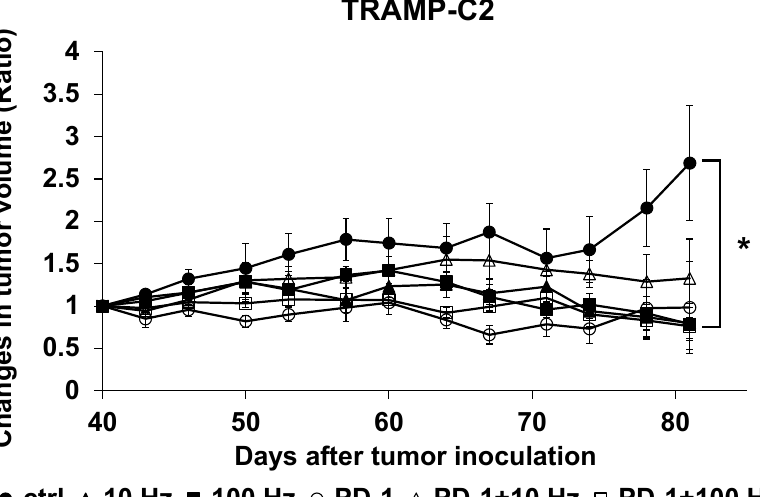
Figure 4. In vivo tumor inhibitory effects of US irradiation and ICIs. TRAMP-C2 cells were subcutaneously inoculated into C5 L/6J mice ( n = 4). After tumor formation, mice were irradiated with ultrasound three times a week. At 14 days after the start of US irradiation, administration of anti- PD-1 antibody was started, and a total of 5 doses were administered. Significant therapeutic effects were observed with 10 and 100 Hz US irradiation, and in the combination treatment group with anti-PD-1 antibody and 100 Hz ultrasound irradiation (*: p < 0.05).